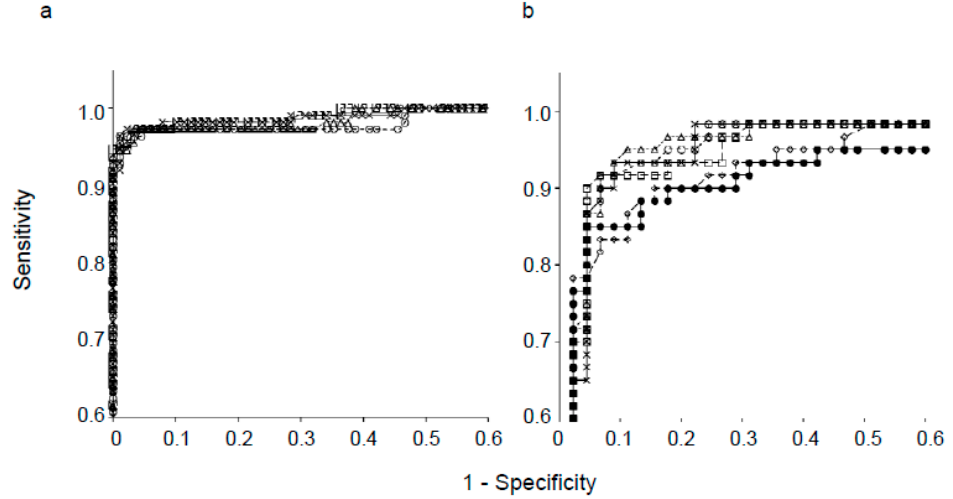
Figure 4. Receiver operating characteristic (ROC) analysis showing no significant difference in diagnostic accuracy between the semi- and fully automatic methods. ( a ) ROC of previous patient data ( N = 200); area under the curve (AUC) = 0.992 (×) vs. 0.987 ( ○ ) with ACSC ( p = 0.24) and 0.993 ( ) vs. 0.989 ( △ ) with CTAC ( p = 0. 37) for the semi- and fully automatic methods, respectively. ( b ) ROC of new patient data for the semi-, fully automatic, and Tossici–Bolt (TB) methods ( N = 105); AUC = 0.965 (×) vs. 0.968 ( ○ ) ( p = 0.37) with ACSC and 0.963 ( ) vs. 0.968 ( △ ) ( p = 0.50) with CTAC for semi- and fully automatic methods, respectively. AUCs of the TB method are 0.925 for ACSC ( ◇ ) and 0.917 for CTAC ( ● ), significantly inferior to our methods ( p = 0.035 and 0.033, respectively).